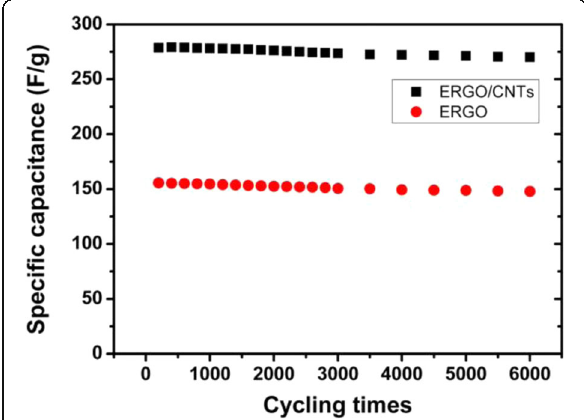
Fig. 8 Cycling rate performance of different electrodes at 1.2 A/g scan current